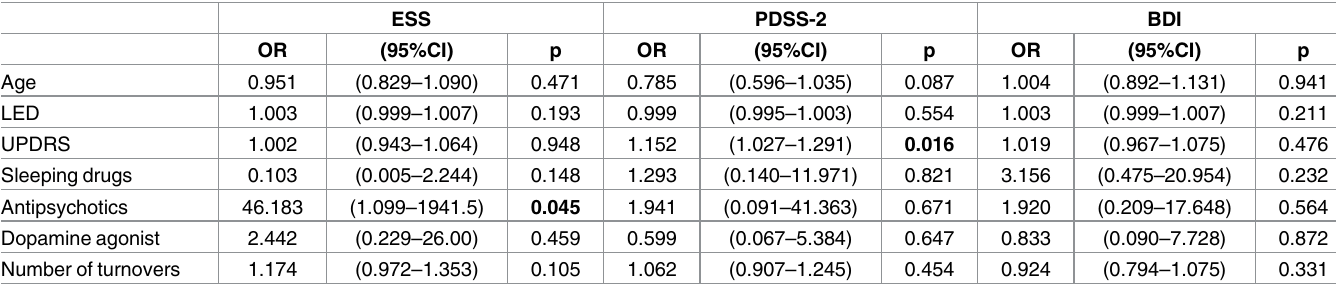
Table 4. Multivariate logistic regression